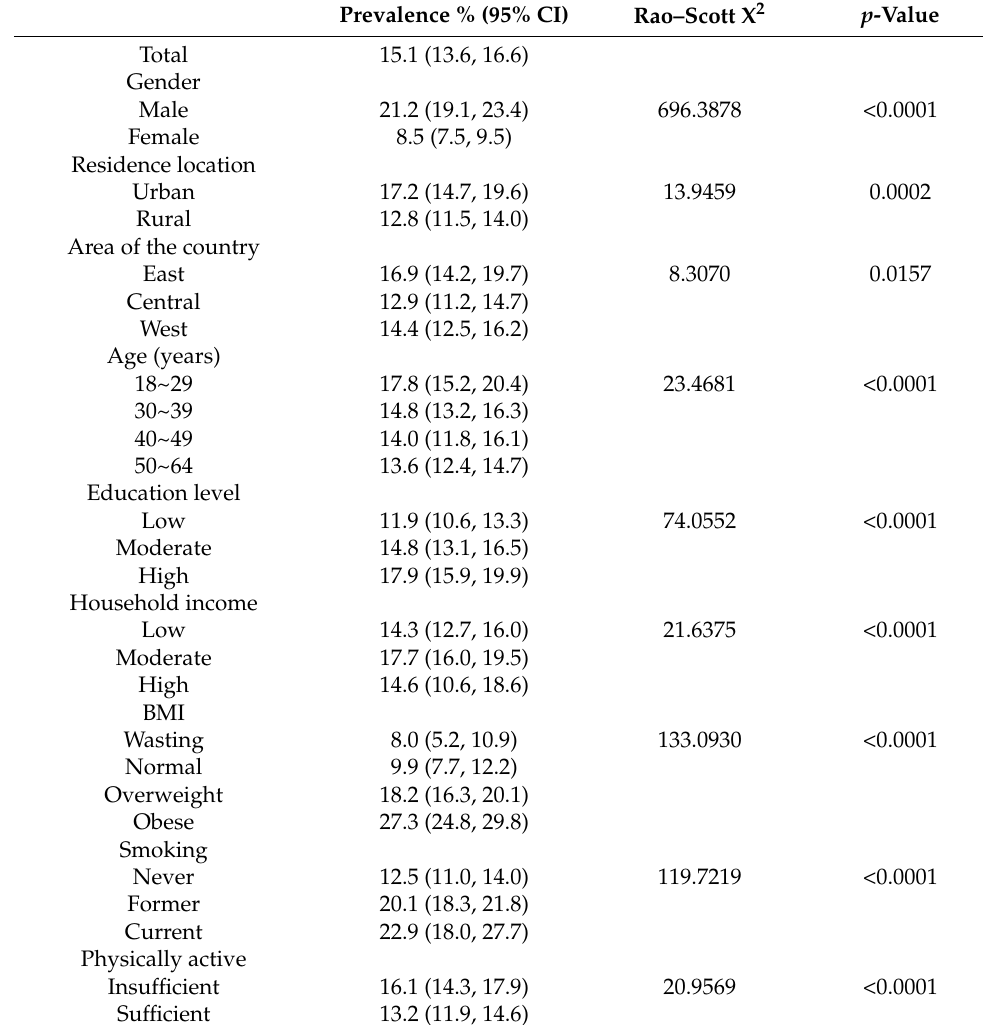
Table 2. Prevalence rate of HUA in different characteristics